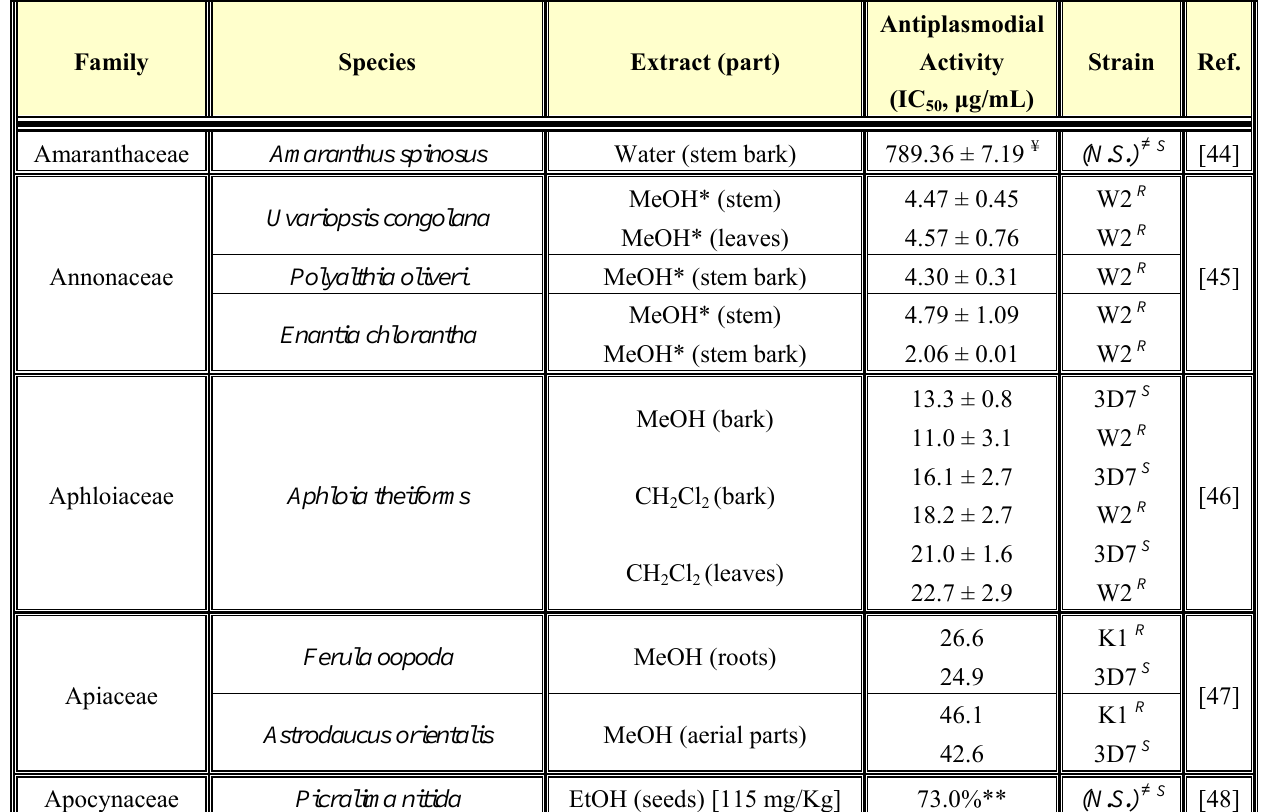
Table 1. Recently-published plant extracts with antiplasmodial activity.